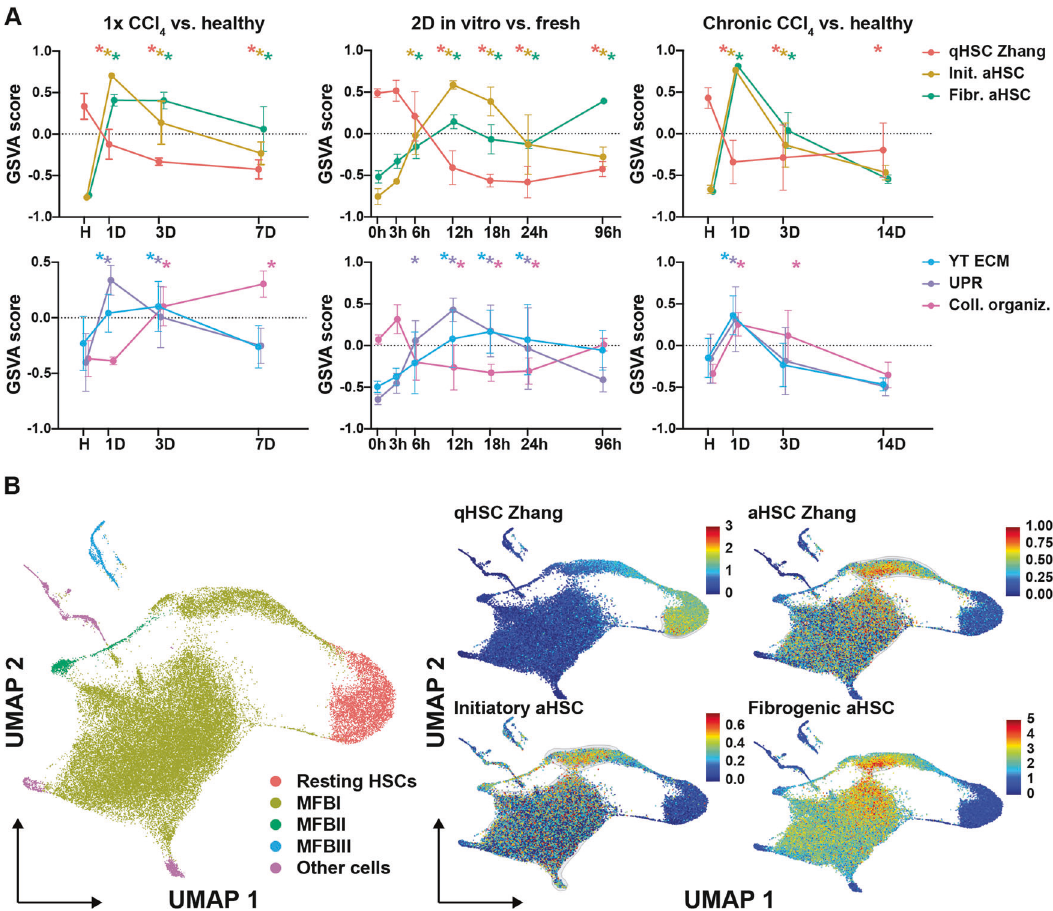
Fig. 4 Transcriptional landscape during HSC initiation, perpetuation and recovery in experimental models of fi brosis. A GSVA on different models of HSC activation using the gene sets de fi ned in Table 1 and bulk RNAseq data from this study. Left panels: 1x CCl 4 . Middle panels: in vitro HSC activation. Right panels: 4 weeks CCl 4 and recovery. For GSVA, the gsva method with a Poisson distribution was run on integer values of RNASeq. Differential activity of gene sets was determined by fi tting a linear model to the output GSVA enrichment scores. Statistics were calculated by empirical Bayes moderation and fdr adjustment. * fdr < 0.05 compared to control condition (healthy, 0 h and healthy respectively). B scRNASeq analysis of mouse HSCs in experimental model of chronic liver disease (3 weeks CCl 4 ) [24]. The identi fi ed MFB clusters are: (i) MFBI: ECM production, (ii) MFBII: in fl ammatory mediator production and (iii) MFBIII: cell division. Left panel shows UMAP dimension reduction and determination of cell clusters based on published criteria. Smaller panels indicate Single-Cell Signature Score for indicated HSC gene sets (Table 1). Blue color represents low expression and increasing expression levels are green to red as shown by the